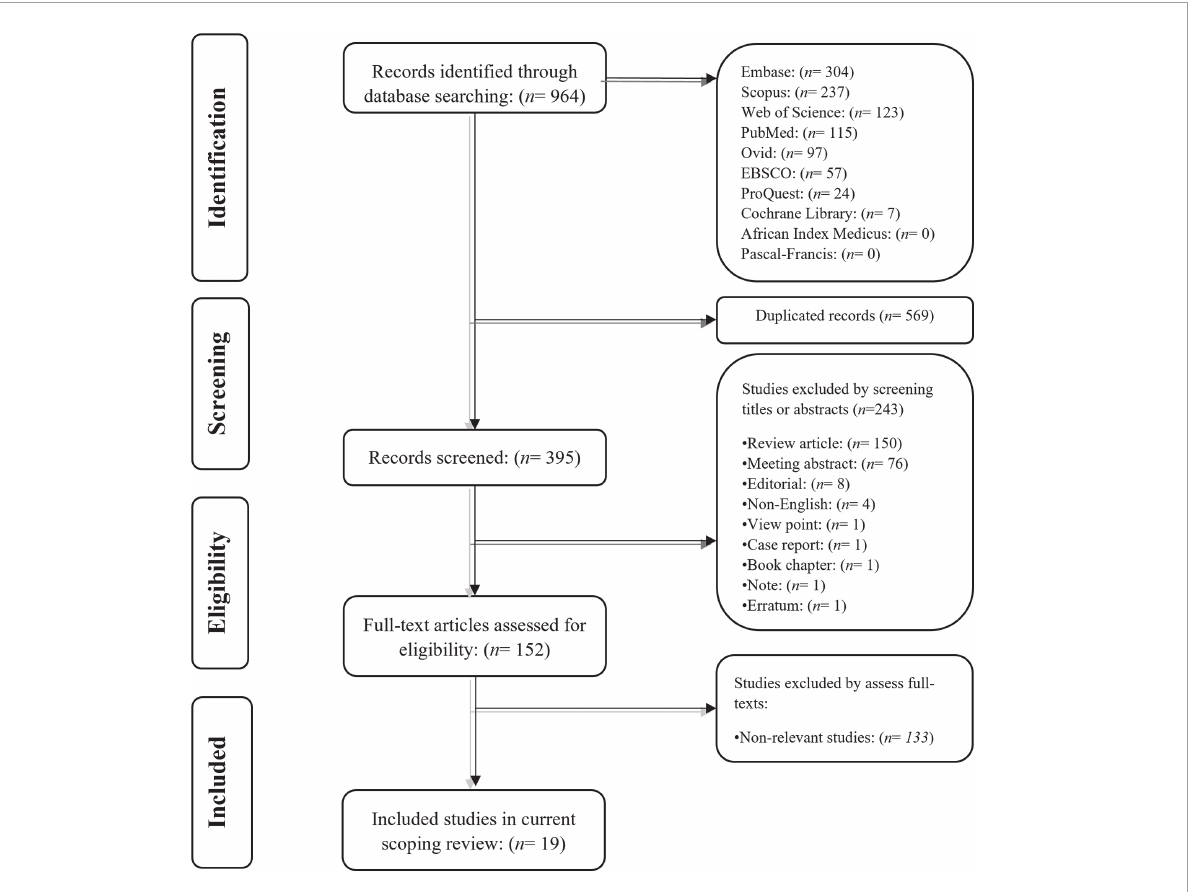
FIGURE1 The study identification